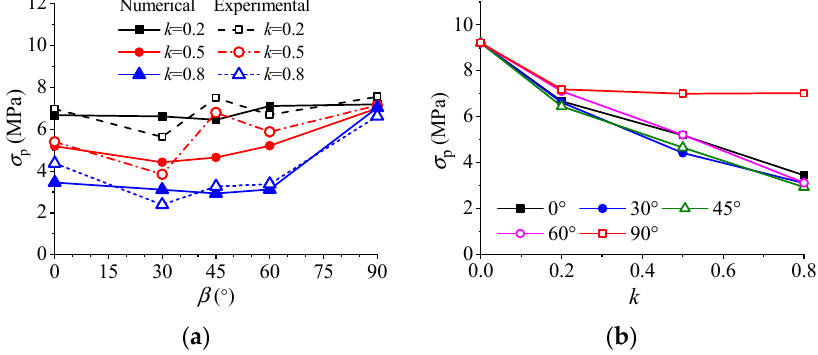
Figure 17. The peak strength vs. the two geometrical parameters by numerical simulation. ( a ) σ p vs. β ; ( b ) σ p vs. k .